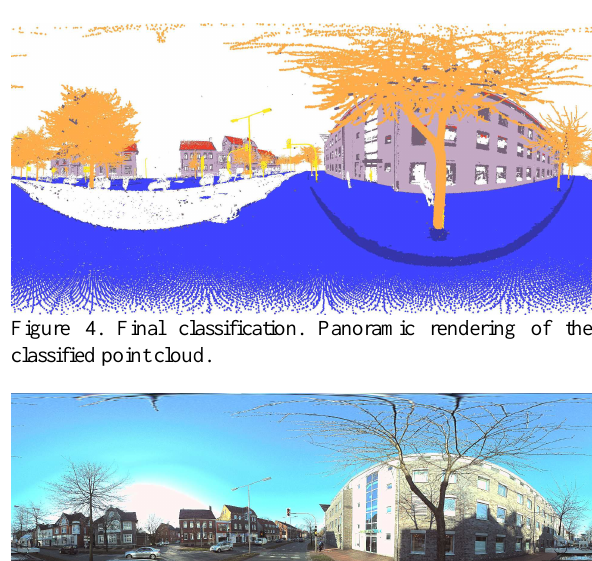
Figure 3. Final classification. Classification into ground (blue), ground inventory (dark blue), wall (light grey), wall inventory (dark grey), roof (red), artificial poles (yellow), trees (orange) and undefined objects (transparent).